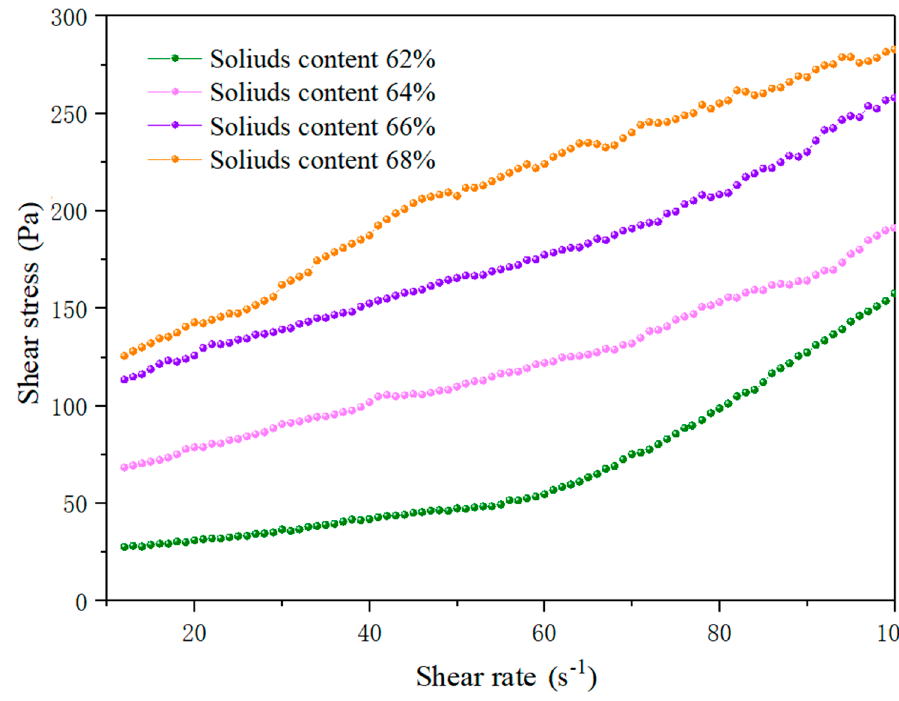
Figure 6. Shear rate versus shear stress flow curves of UCPB after ultrasonic wave action. Table 6. Fitting equation parameters of UCPB after ultrasonic wave action.